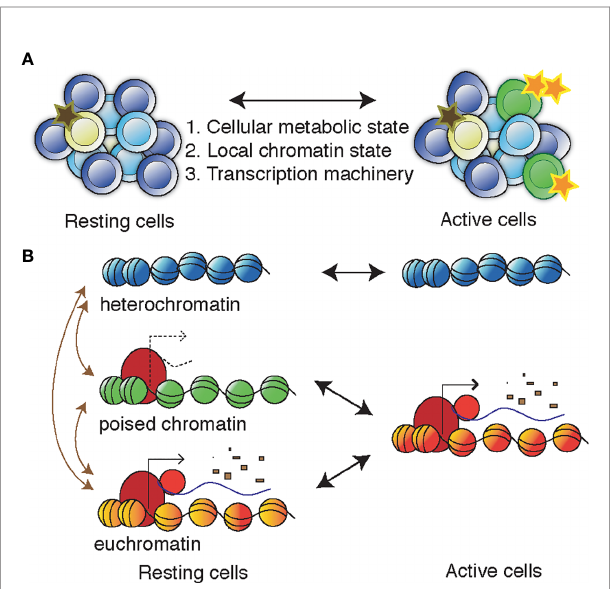
FIGURE 1 | Controlling the proviral/oncogenic activity during T cell activation. (A) A heterogenous population of cells can switch between different levels of activity resulting in changes of 1) the metabolic state of the cell, 2) the permissiveness of the chromatin of the provirus/oncogene that can adopt heterochromatin, euchromatin or poised chromatin structures, and 3) the availability of the transcriptional machinery, including transcription factors but also elongation, splicing and polyadenylation factors. (B) In the nucleus, the genetic locus of the provirus/oncogene in found in heterochromatin, poised chromatin (non-productive), or euchromatin (productive). Upon cell activation, the poised chromatin can allow productive transcription whereas the heterochromatin remains inactive. Transitioning between chromatin states (maroon arrows) is generally not associated with cell activation, instead it is caused by (de-) differentiation or chromatin resetting and can be induced be epigenetics drugs such as inhibitors of HDACs, BET domains, or